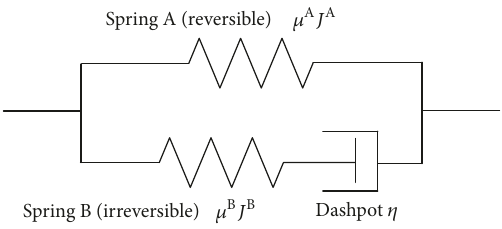
Figure 2: A Schematic illustration of a viscoelastic model for dielectric elastomer. It consists of two parallel elements: one element is a spring A and the other is a spring B which connected a dashpot in